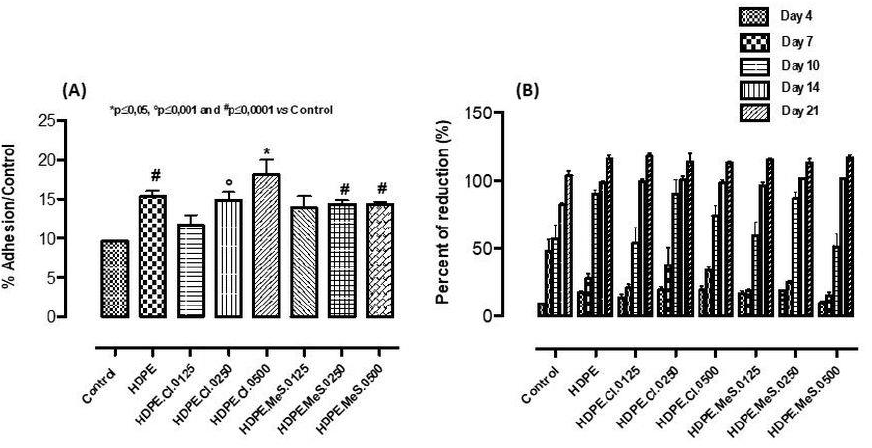
Figure 10. ( A ) hMSC adhesion after 48 h of incubation time and ( B ) hMSC proliferation at 4, 7, 10, 14 and 21 days of culture time.